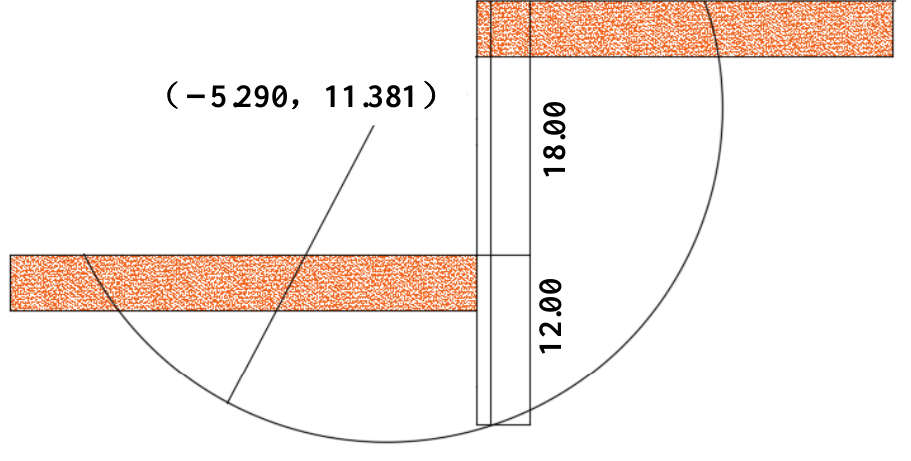
Figure 6. Calculation diagram of foundation pit stability.